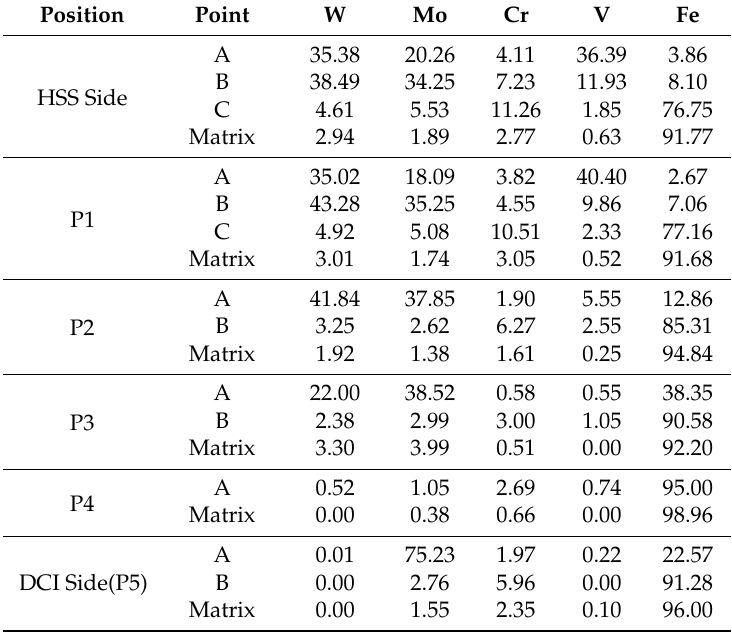
Table 3. Chemical composition of the different carbides (wt.